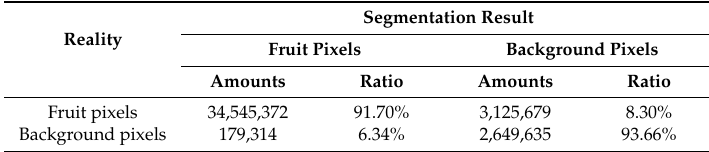
Table 3. Confusion matrix of segmentation